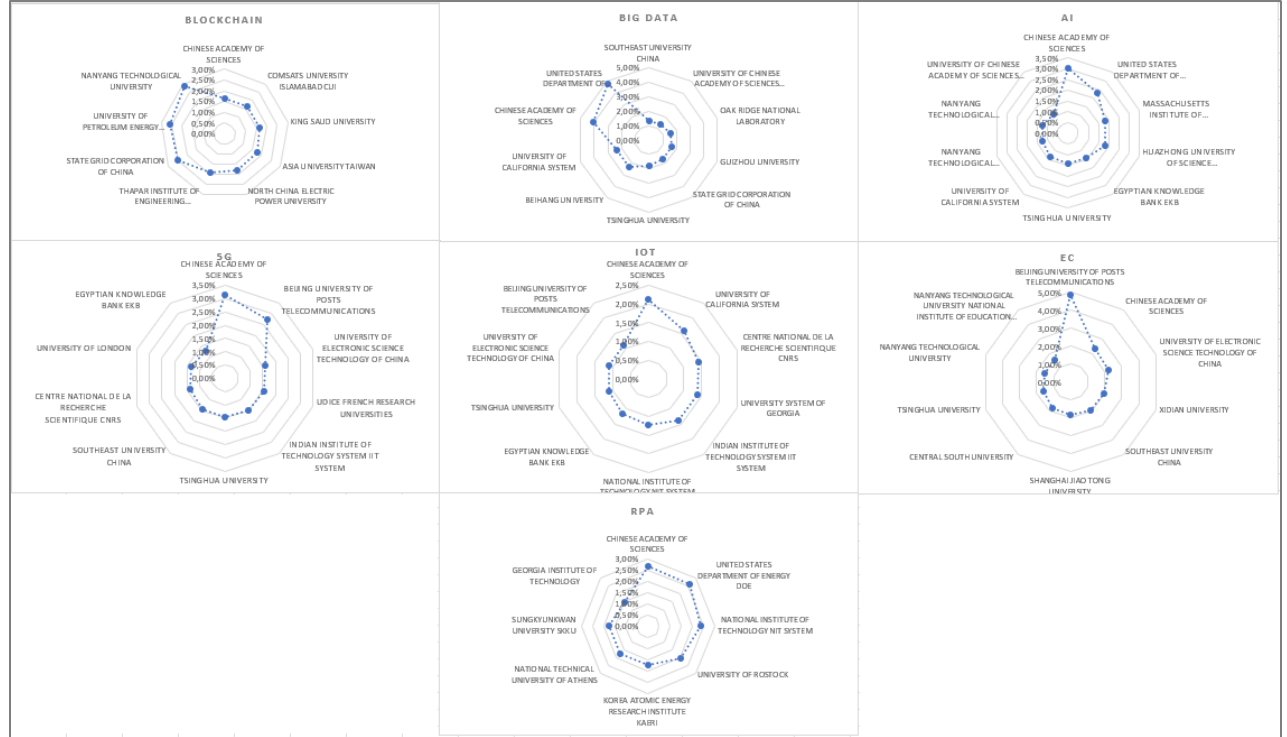
Figure 6. Publication analysis by affiliations.